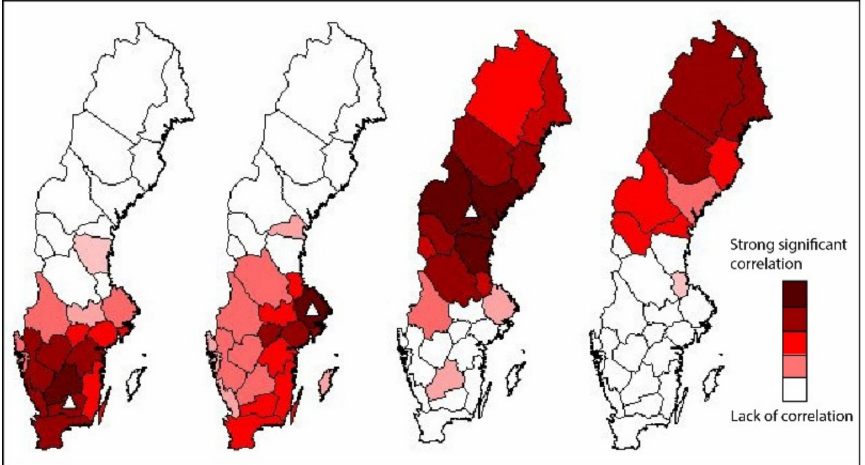
Figure 6. Examples that show how the determination of provenance works. The white triangles show areas where analysed spruce wood originates from. The darker the colour the stronger the correlation between samples and reference chronologies developed from each